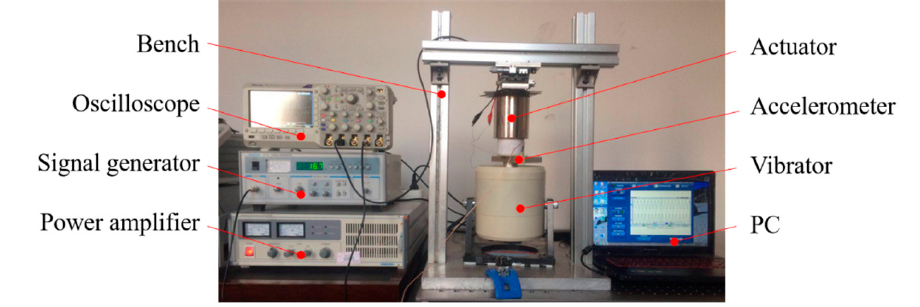
Figure 13. Vibration experimental setup.